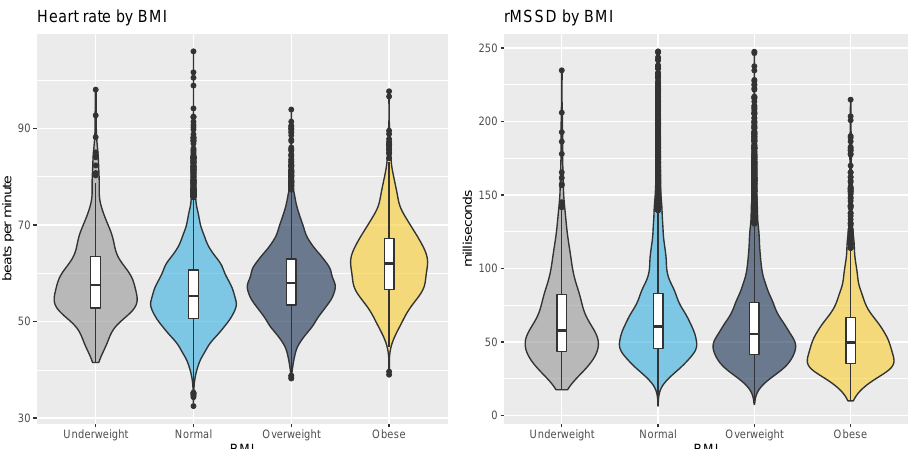
Figure 5. Resting heart rate and HRV by BMI. Resting heart rate is the lowest for the normal category, and similarly, HRV is the highest for the normal category. The largest deviation for both heart rate and HRV is found in the obese category, with the highest resting heart rate and lowest HRV. There was almost no correlation between heart rate and age ( p = 0.35, r = − 0.01), while the correlation between rMSSD and age was moderate ( p < 0.05, r = − 0.35,